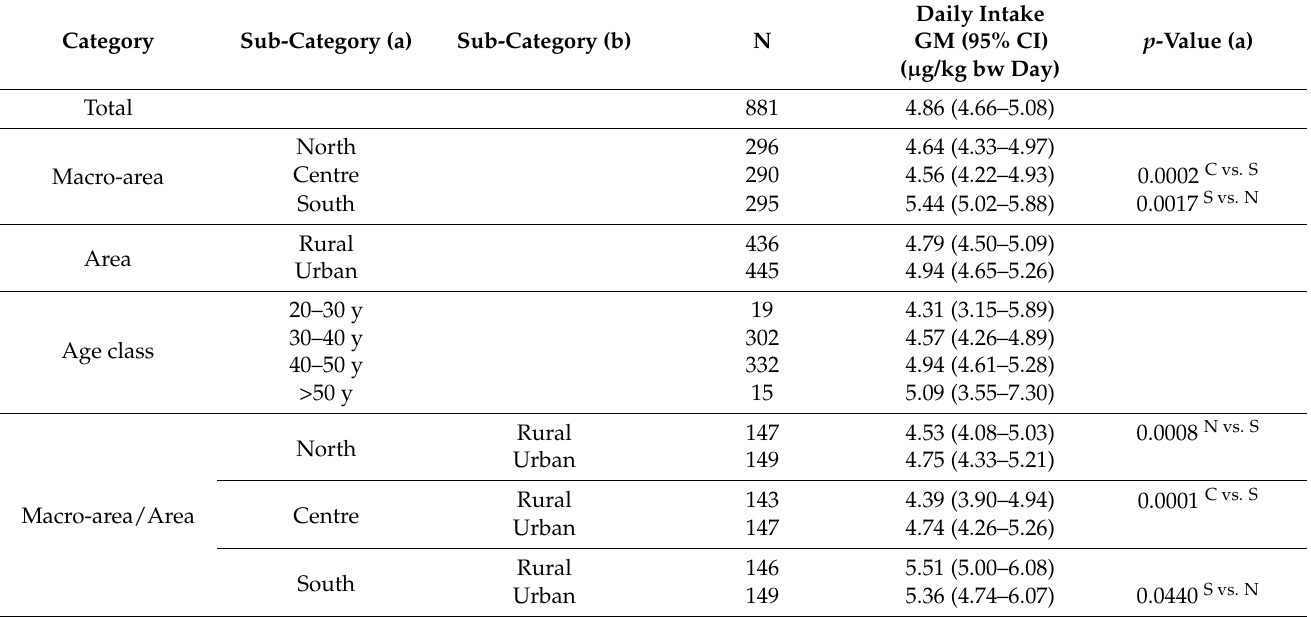
Table 7. Estimated daily intake ( µ g/kg bw per day) of DEHP in Italian women (N = 881) according to residing areas and